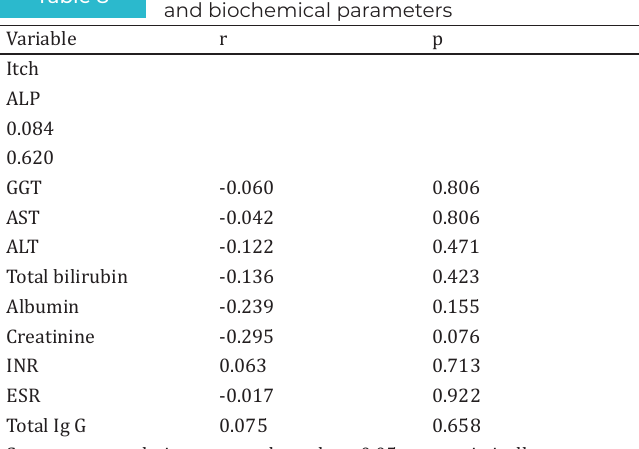
itching and biochemical parameters is summarized in Table 8. According to the evaluation, no statistically significant correlation was found between itching and any of the biochemical parameters Evaluation of the relationship between